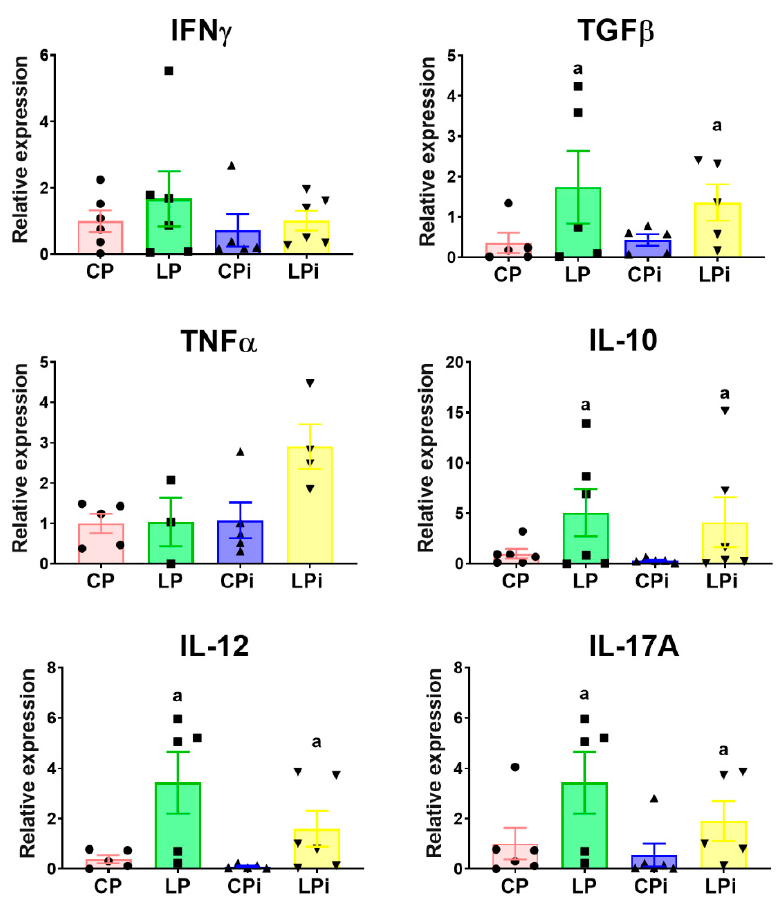
Figure 5. Cytokine expression in the duodenum from malnourished BALB/c mice infected with L. infantum. il-12, ifn γ , tnf α , tgf β and il-17 mRNA expression levels measured by qPCR in the duodenum of each experimental group. The values are expressed as normalized ratios between the target gene expression and the geometric median of the ATP-5, GAPDH and CYC-1 genes. Statistical differences due to (a) diet ( p < 0.001) were determined by two-way ANOVA. CP: animals fed 14% protein diet; LP: animals fed 4% protein diet, CPi: animals fed 14% protein diet and infected; LPi: animals fed 4% protein diet and infected.